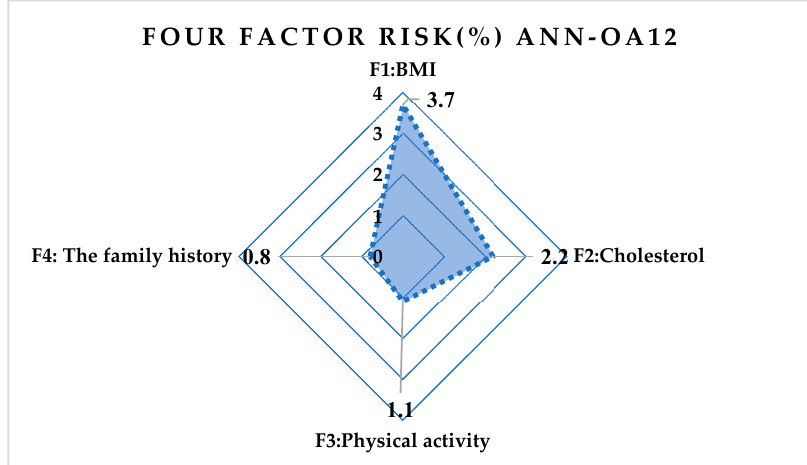
Figure 8. Influence of four factors on the resulting risk and error of the ANN-OA12 model through five iterations.